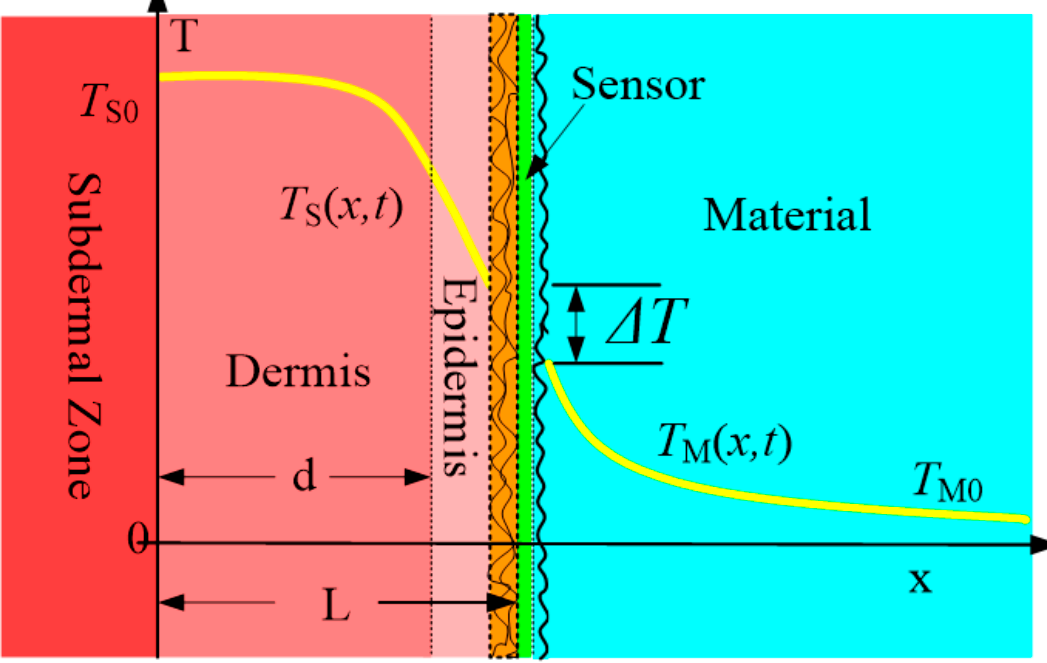
Figure 2. Thermal contact